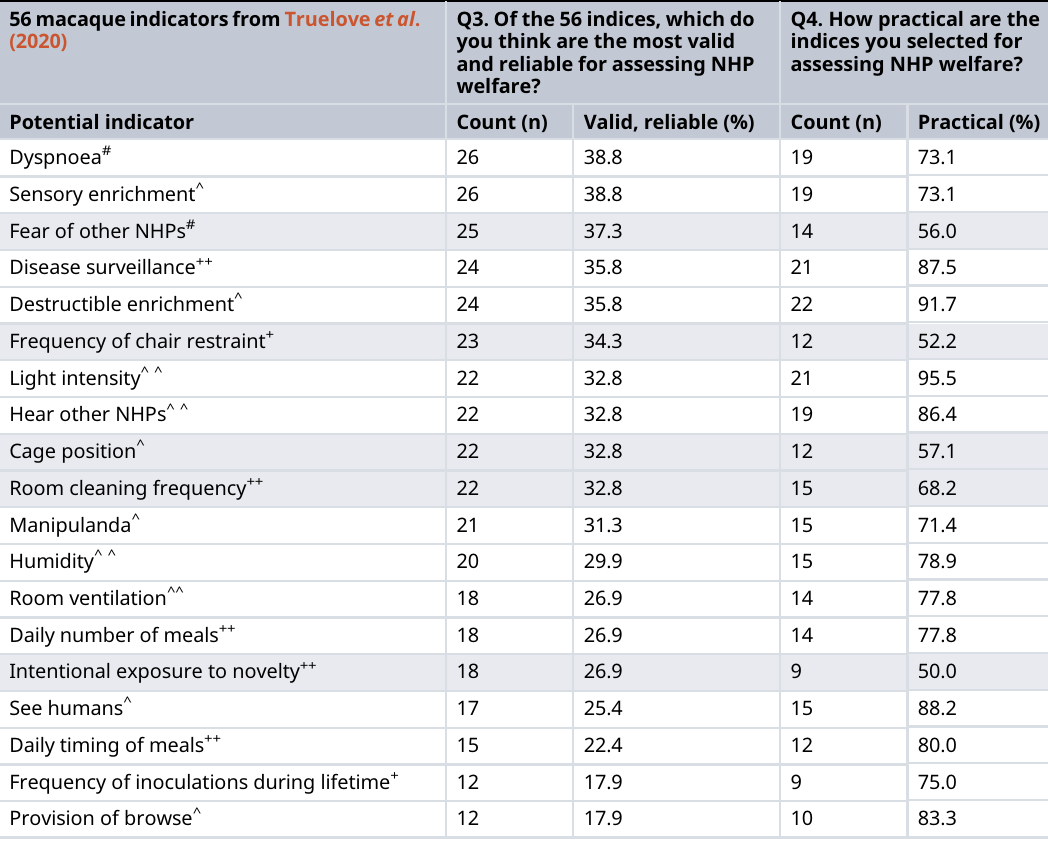
Round 2 – measurement of selected welfare